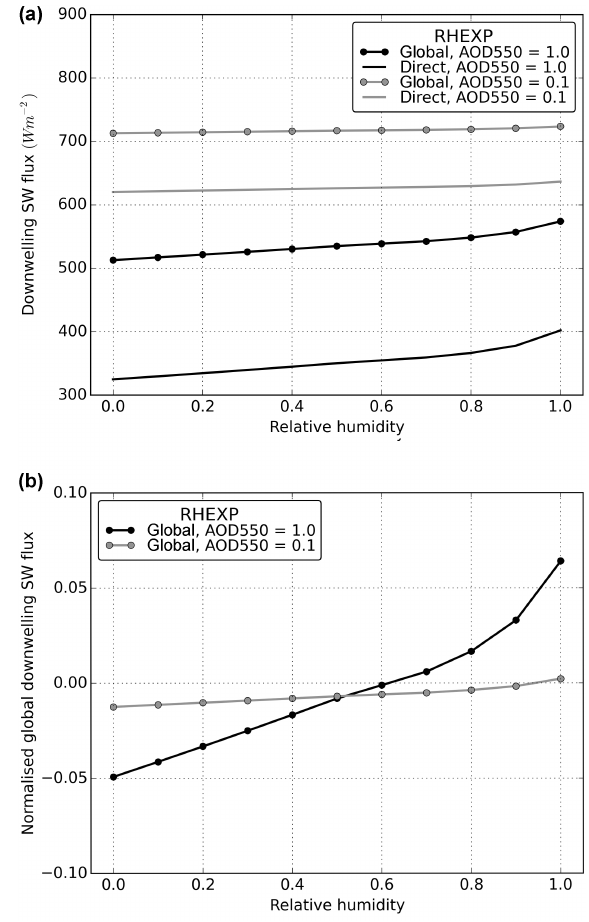
Figure 6. (a) Global (dotted continuous curves) and direct (contin- uous curves) SWD fluxes, as a function of relative humidity, simu- lated using MUSC with the hlradia radiation scheme for AOD550 values of 0.1 (grey) and 1.0 (black). (b) Similar to panel (a) but shows global SWD flux normalised relative to a corresponding ex- periment run using the IFS radiation scheme. The IFS scheme as- sumes a RH of 80% for land